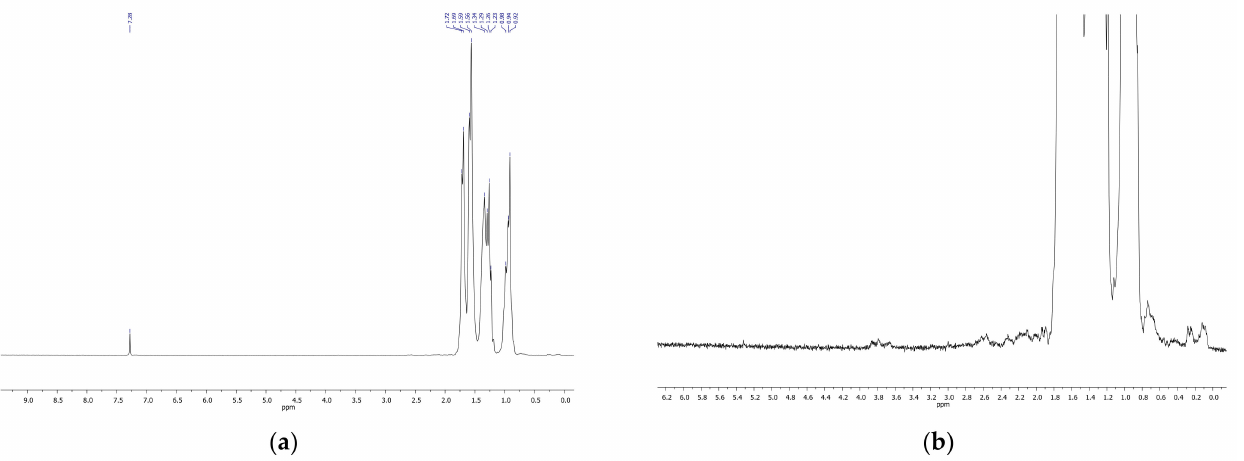
Figure 7. 1 H-NMR spectrum of the initial mixture of cis- and trans-decalins in a wide range of chemical shifts ( a ) and in the narrow range of 0–6 ppm ( b